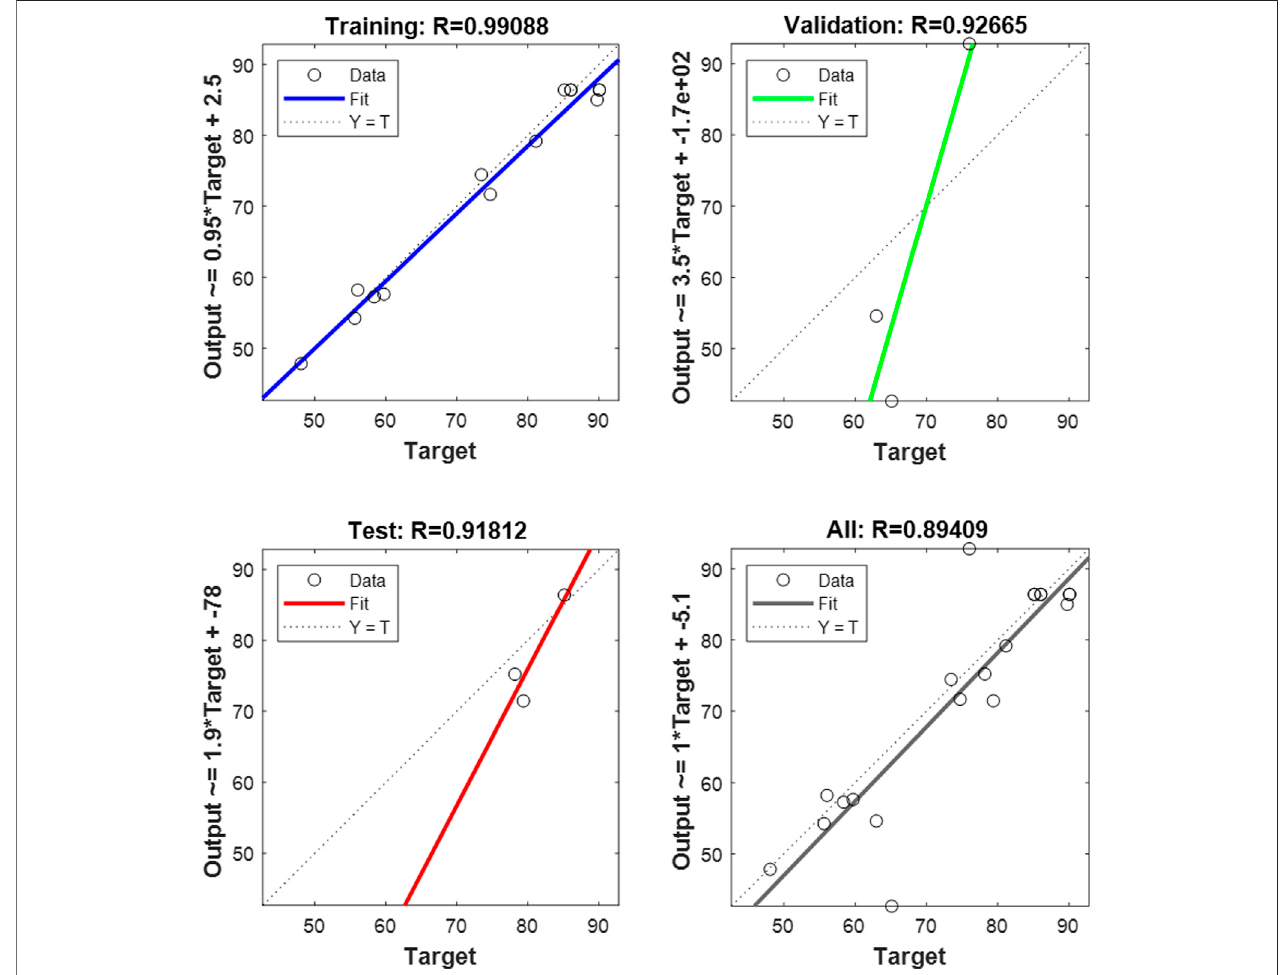
FIGURE 8 | Regression plots for the selected